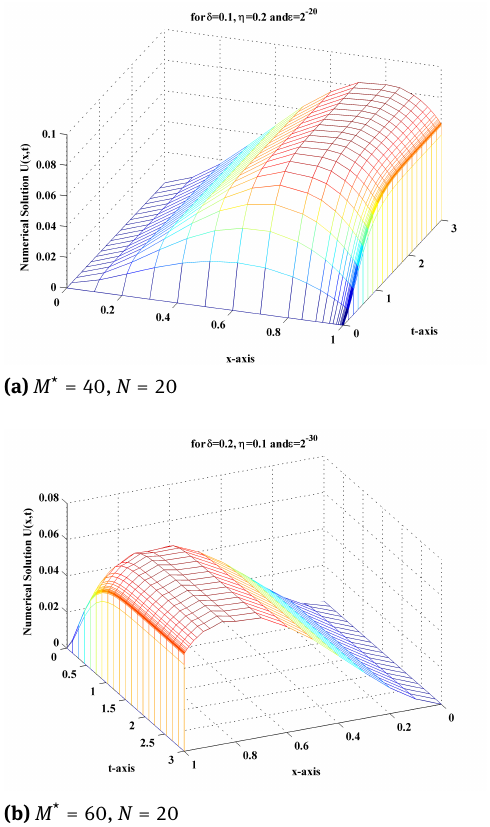
Fig. 8: Numerical solution of example 5.3, using uniform mesh and adaptive mesh for three different time level with ε = 2 −30 , δ = 0.1 , η = 0.2 , M=60 and N=20.